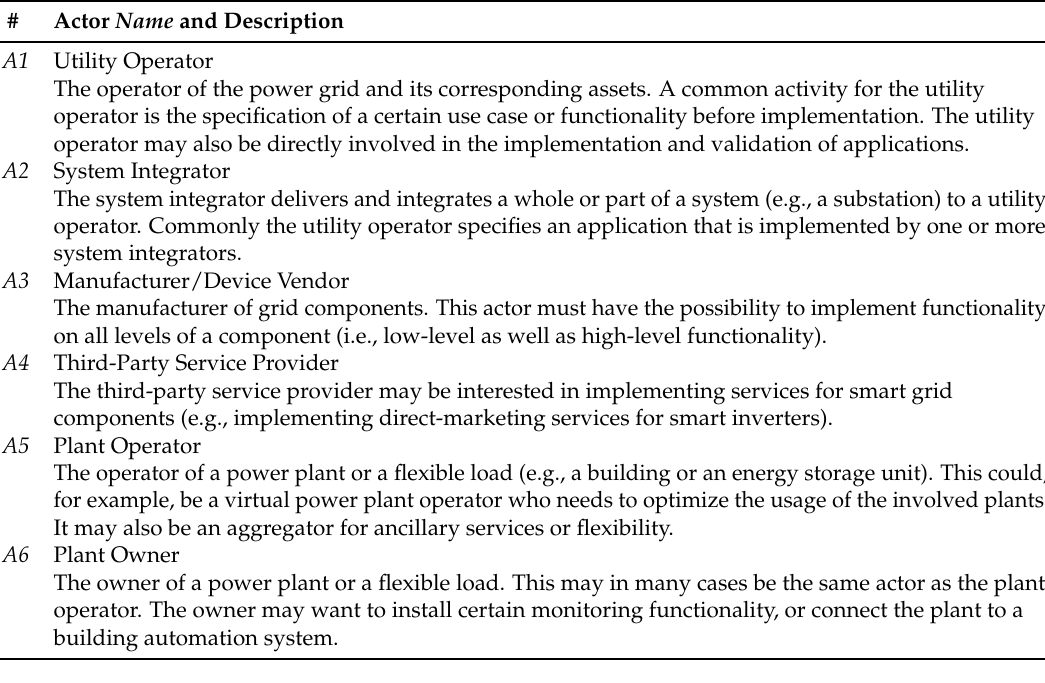
Table 1. Actors and stakeholders involved in the rapid engineering